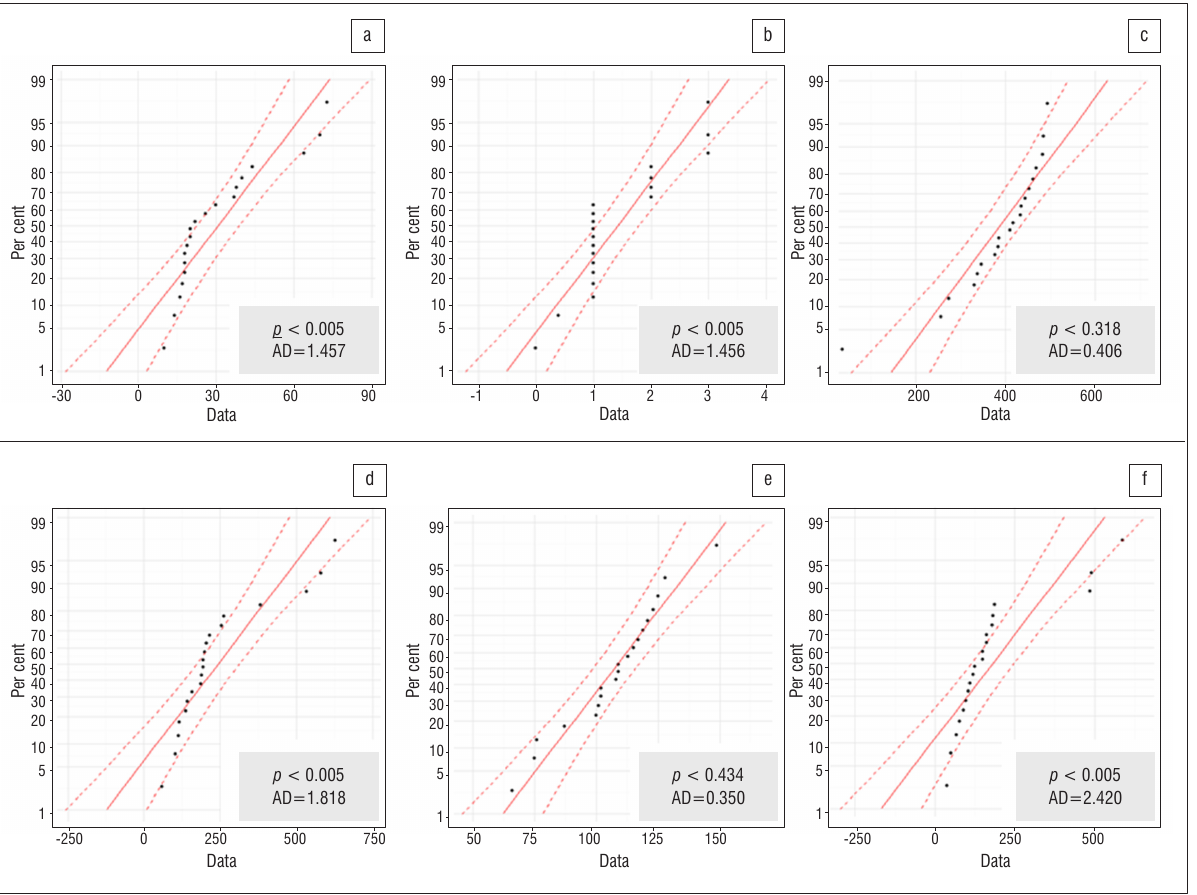
Figure 3: Probability distribution for the activity concentration of (a) 238 U, (b) 235 U, (c) 228 Ra, (d) 228 Th, (e) 226 Ra and (f) 232 Th. In all figures, the data on x -axis are the activity concentrations in Bq/kg. The Anderson–Darling (AD) statistic for each radioactive nuclide is displayed on each hazard indices: H , H , I and Ra indicate that the LSA phosphogypsum ex in eq γ can be utilised as building material if used superficially or with restriction.